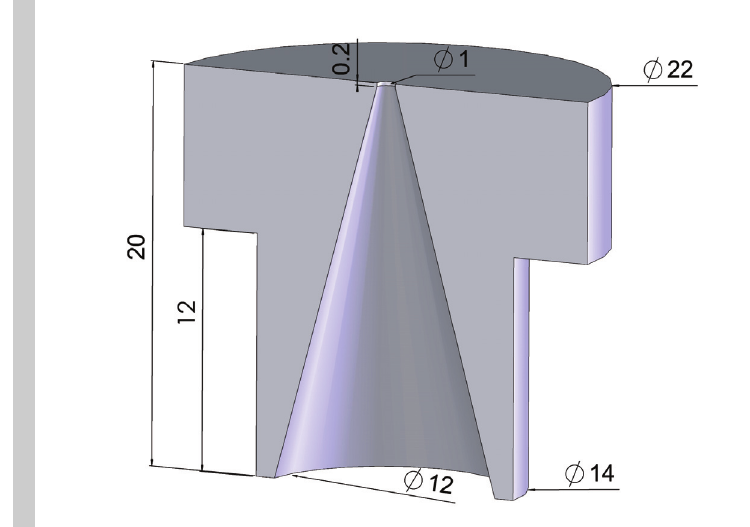
Figure 1: Cross-section of the orifice die used in this study (dimensions in